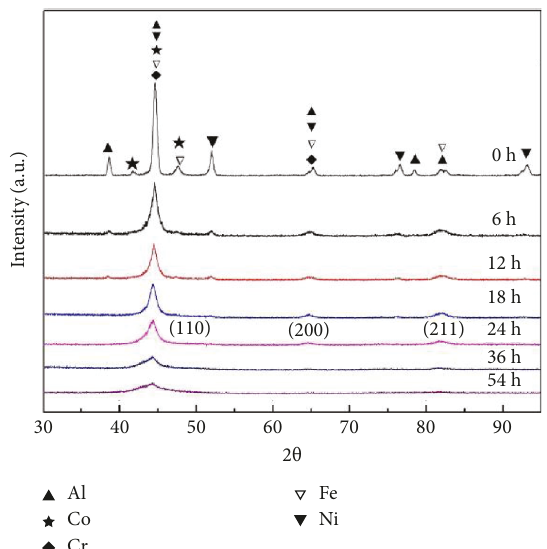
Figure 3: XRD patterns of AlCoNiCrFe HEA with respect to milling time